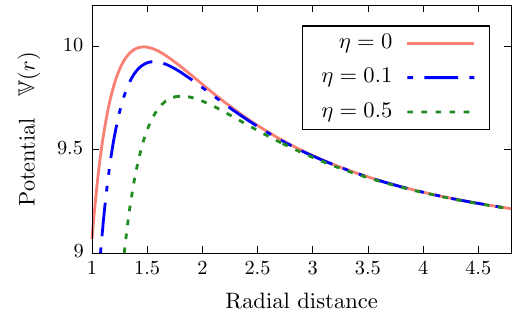
Fig. 3 The above figure illustrates the scalar field potential V ( r ) from Eq.(16)fordifferentvaluesof η .Wesettheotherparametersat a = 0 . 1, l = 2, ω = 3, m = 0, r s = 1